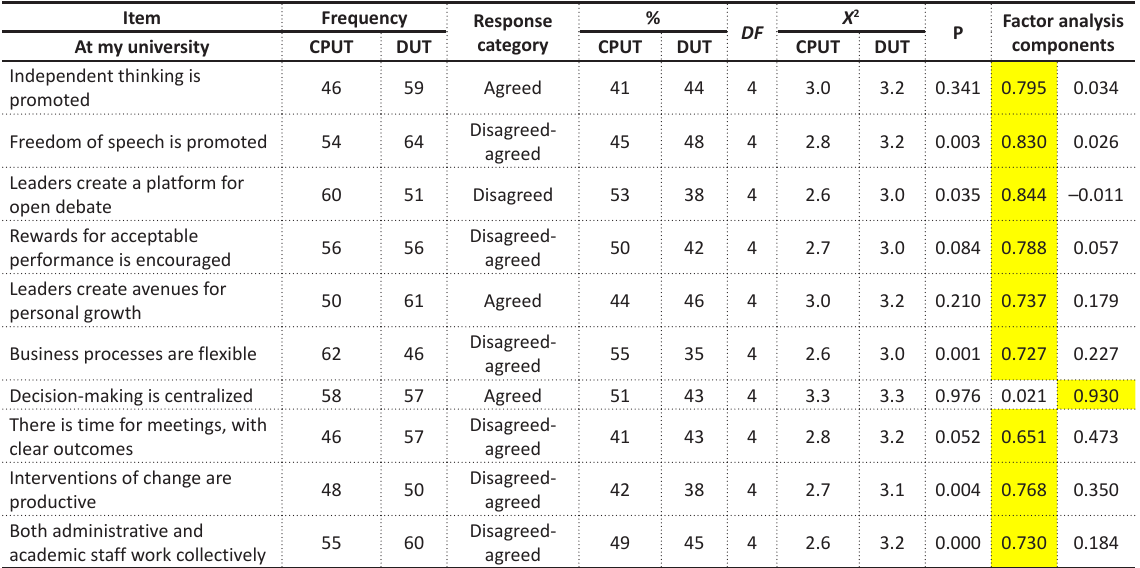
Table 4. Leaders’ traits influencing